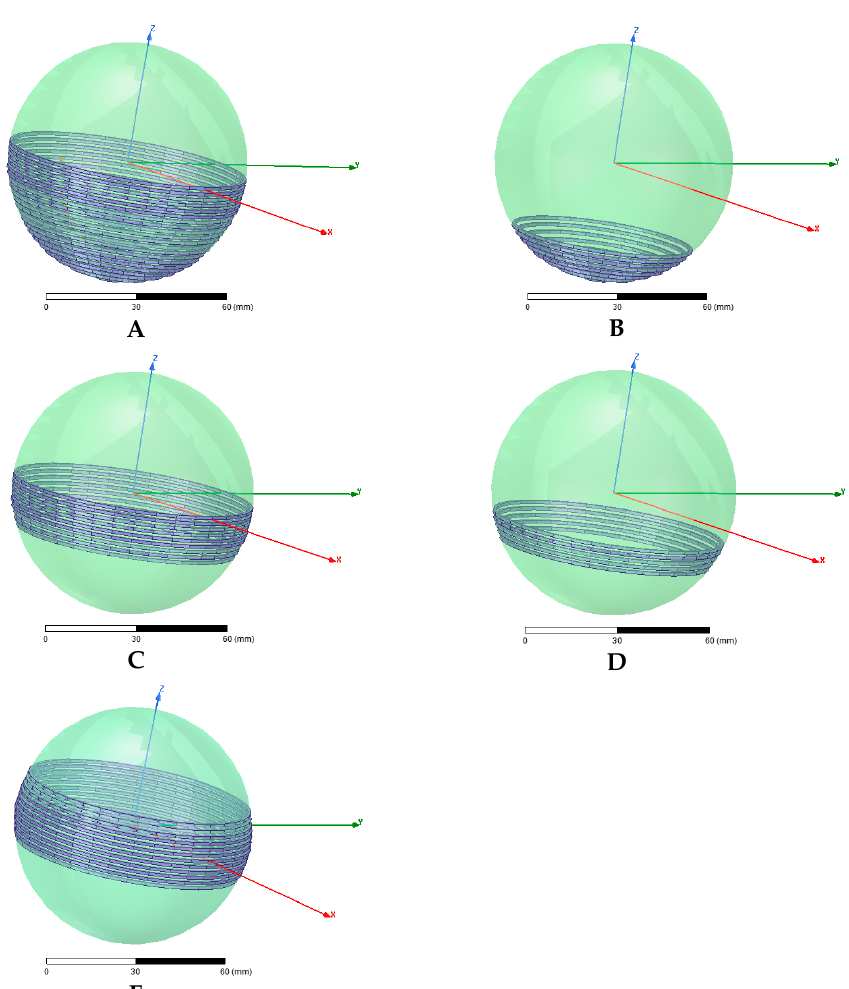
Figure 4. Basic winding methods for the transmitter coil: Cases ( A – D ) cover the hemisphere; case ( E ) covers the middle area (equator winding).